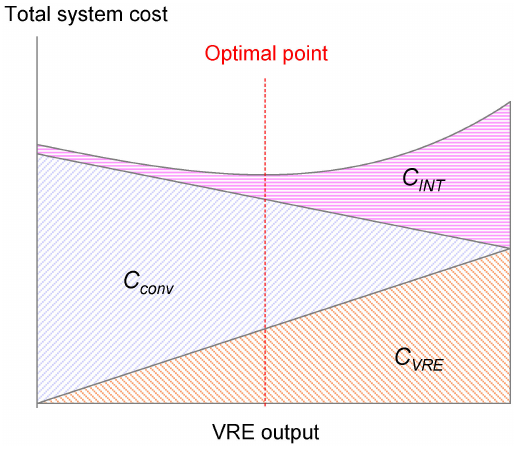
Figure 1. An illustrative diagram of integration